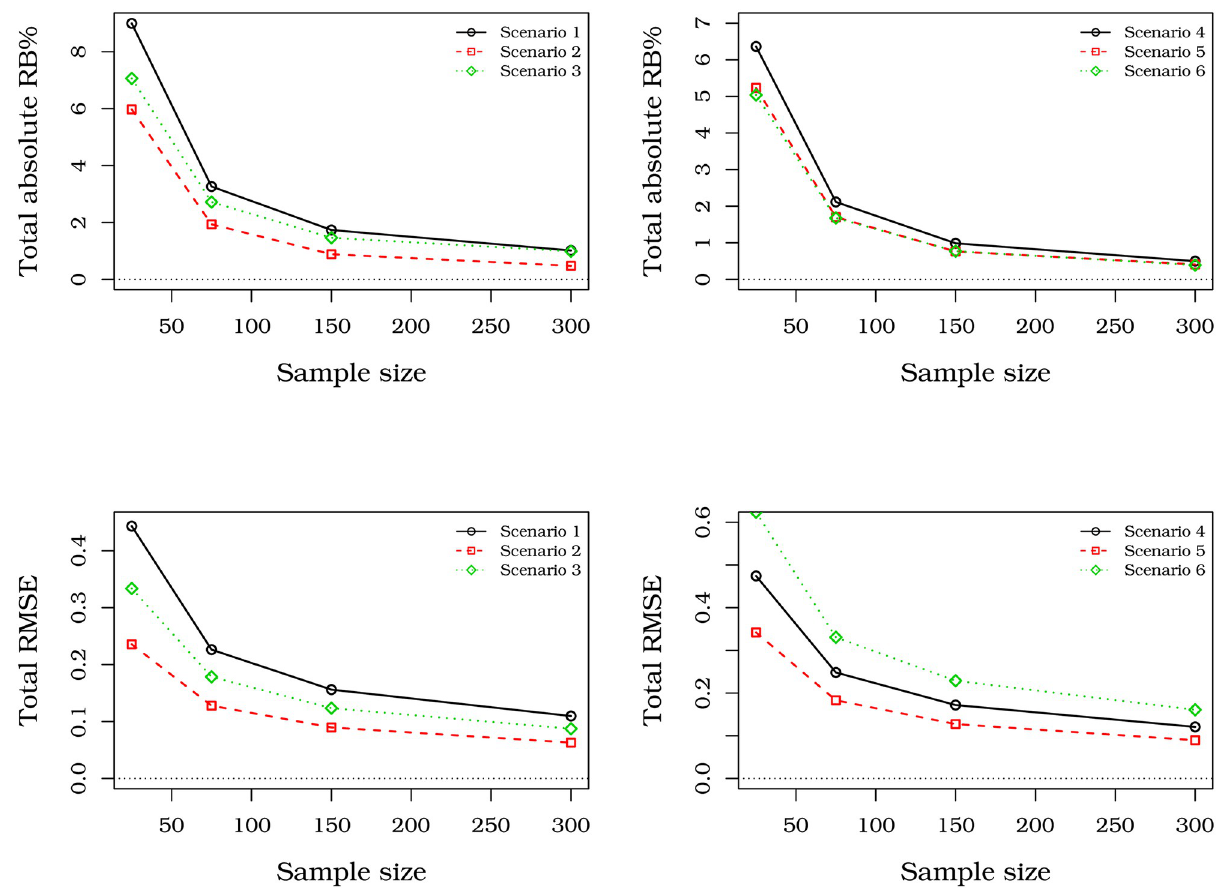
Fig 5. Total absolute RB%s and total RMSE of the MLEs from UBXII distribution with different sample sizes.